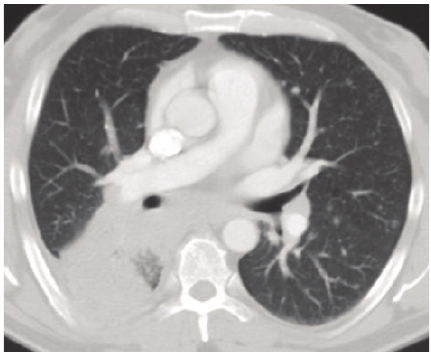
Figure 2: CT scan chest at presentation showing areas of consolida-